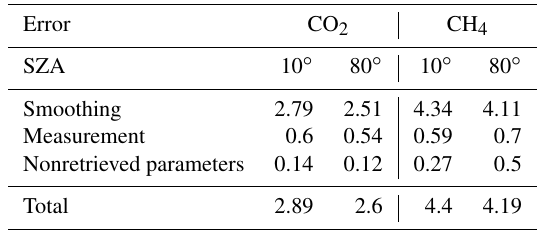
Table 2. The total column errors for CO 2 and CH 4 profiles for CHRIS for the two SZAs. The uncertainties are shown in percent- ages